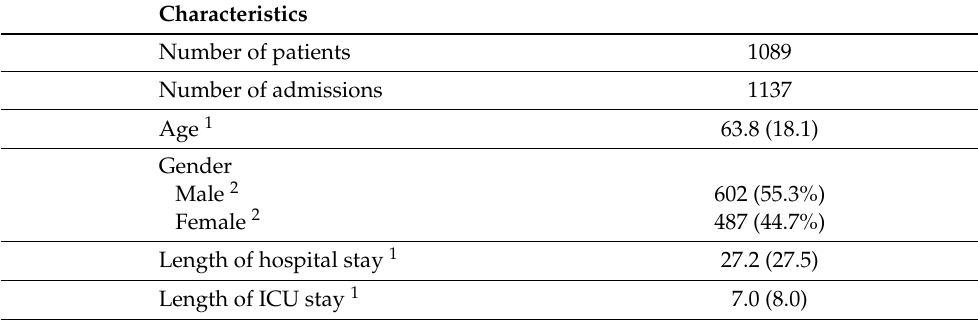
Table 1. Dataset